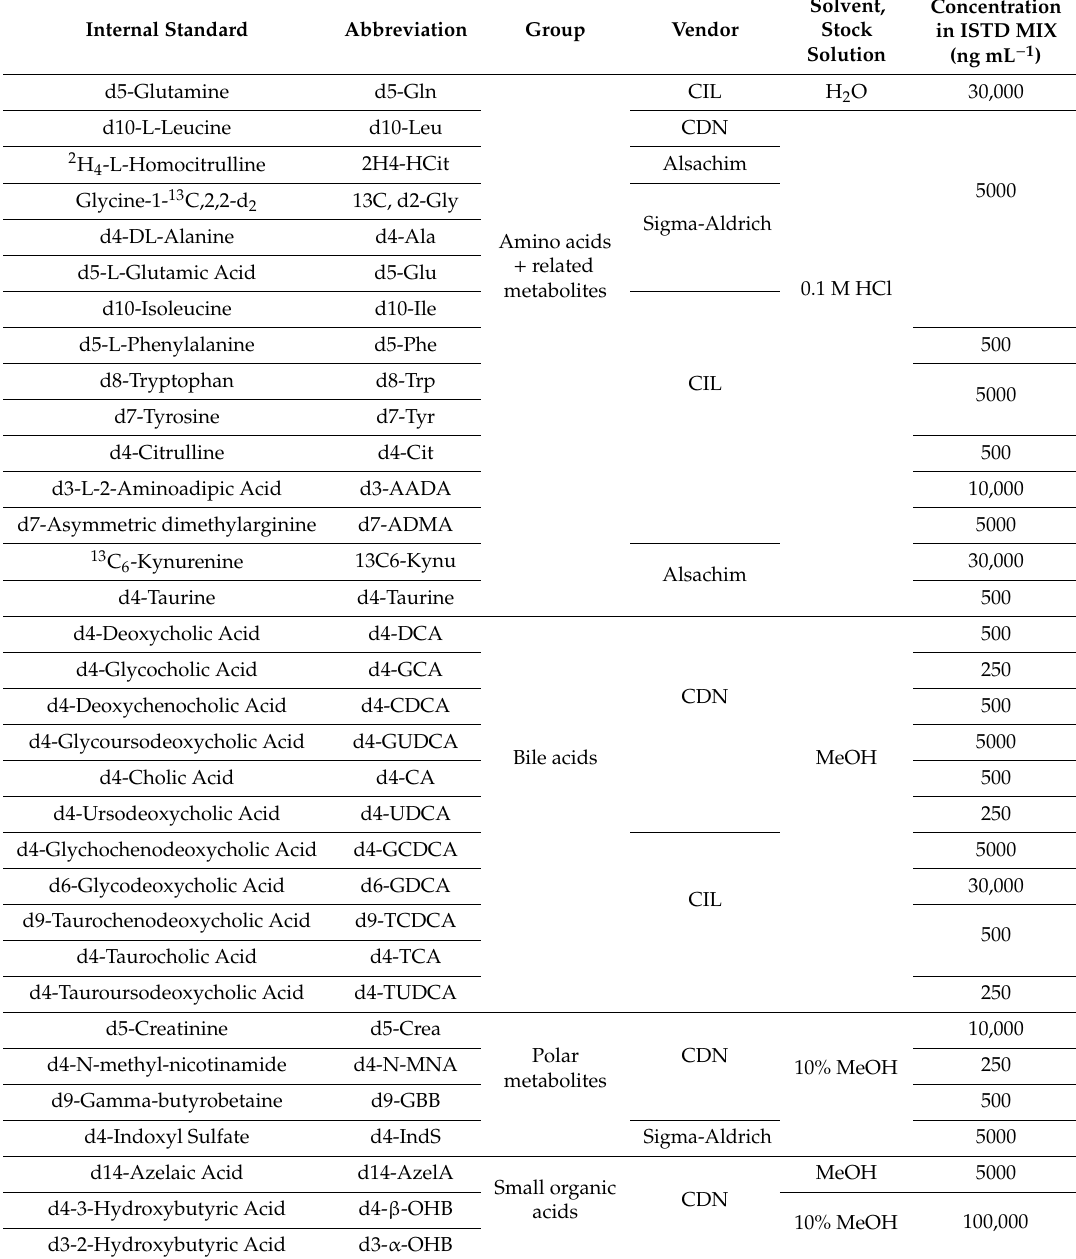
Table 5. Internal standards, with concentrations in ISTD MIX, acquired for quality control and for